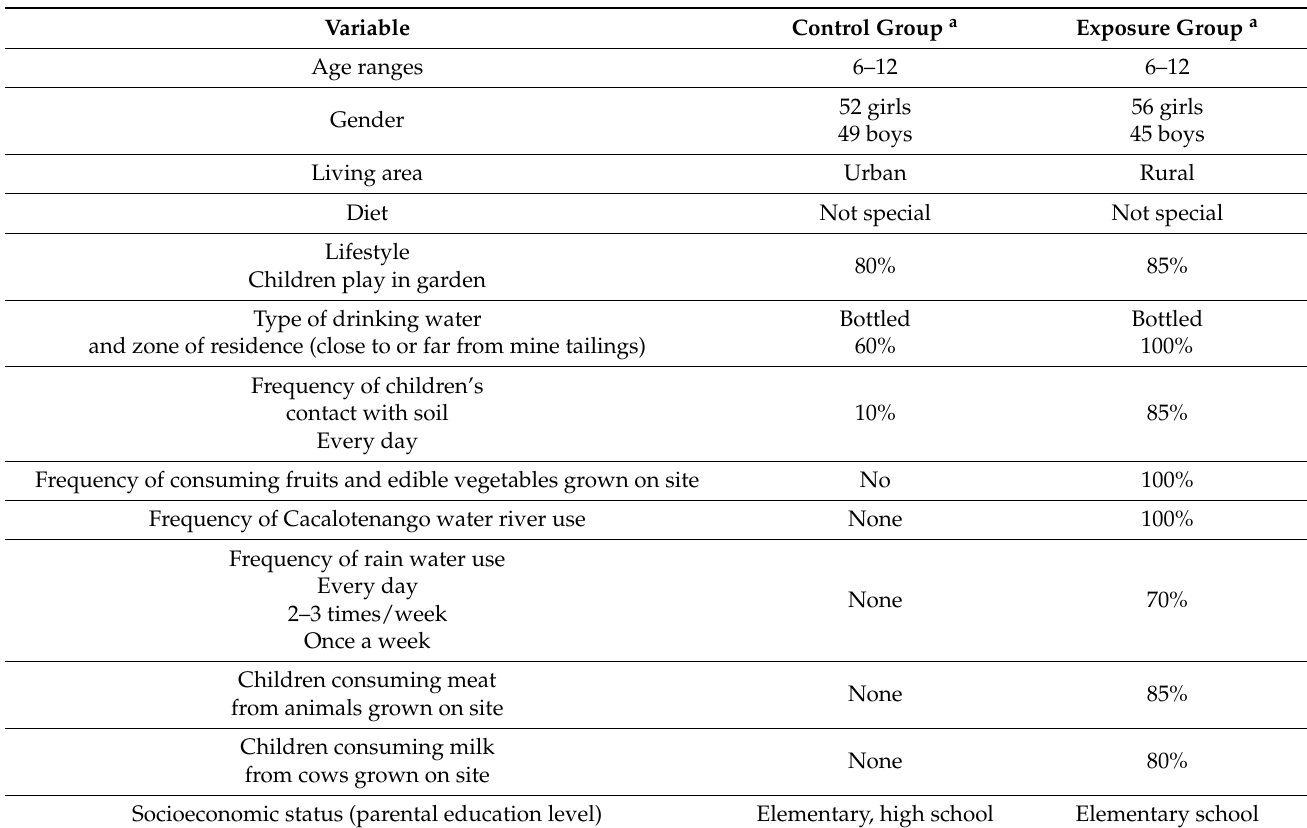
Table 1. Sociodemographic characteristics in the (El Fraile, Taxco de Alarc ó n)-exposure and (Chilpancingo)-control